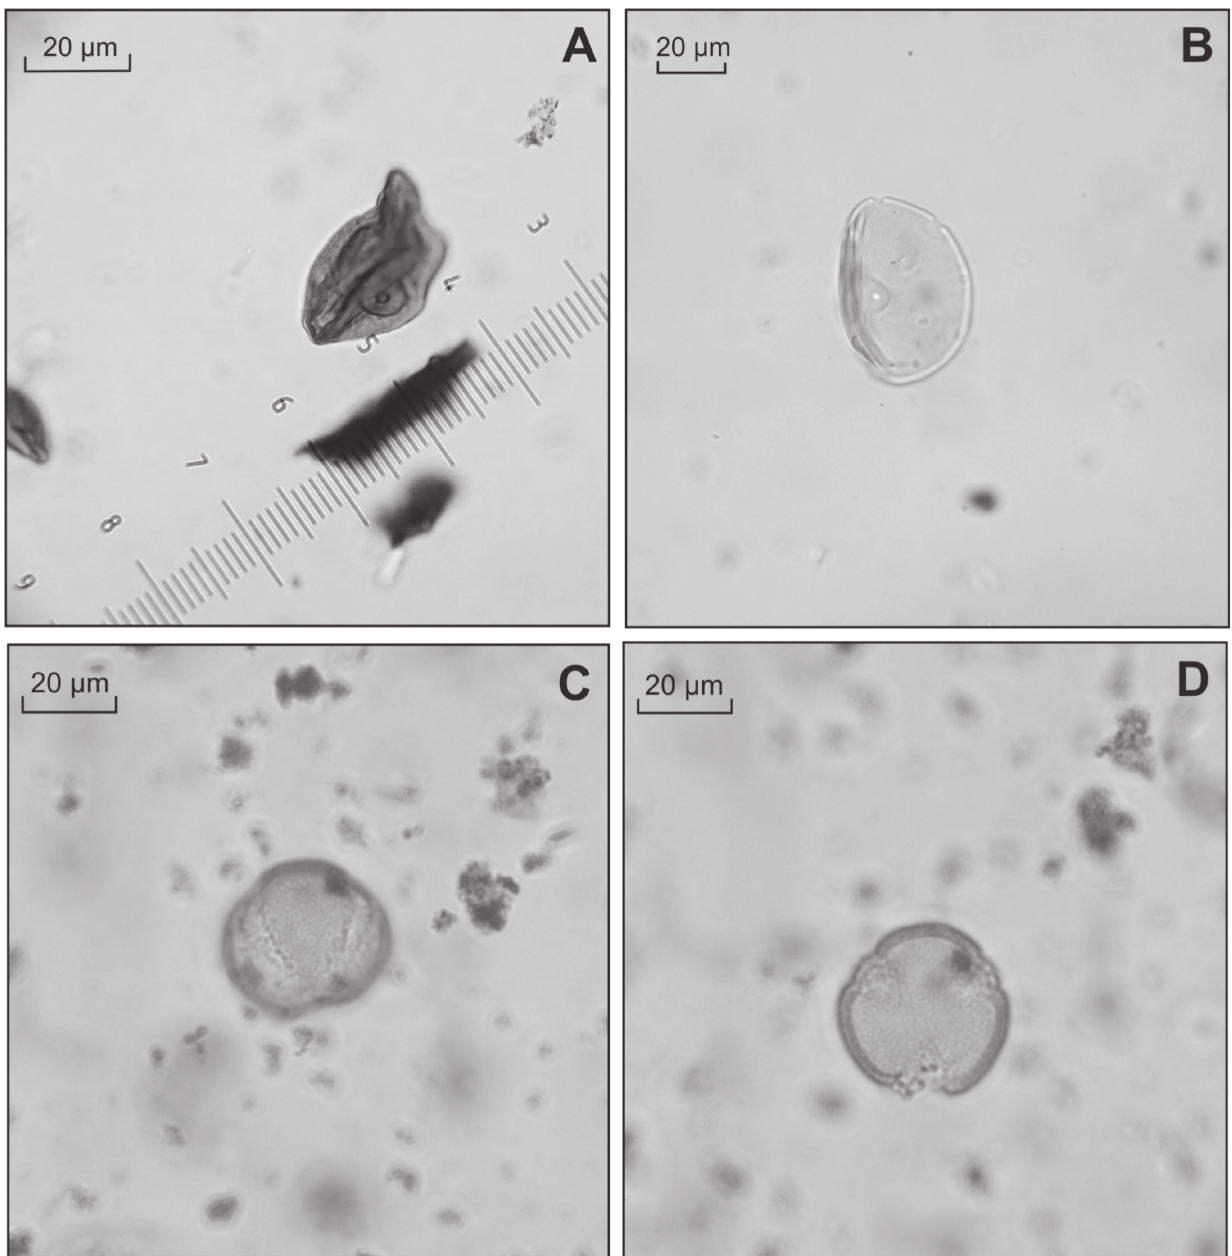
Fig 8. Images of pollen types identified in the core. (A) Highly folded cereal pollen (probably Hordeum -type) from 140 – 139 cm with a mean size of 39 μ m, annulus of 8.5 μ m and pore of 3 μ m; (B) Juglans pollen identified at 97 – 96 cm; (C) Platanus (equatorial view) from 75 – 74 cm; (D) Platanus (polar